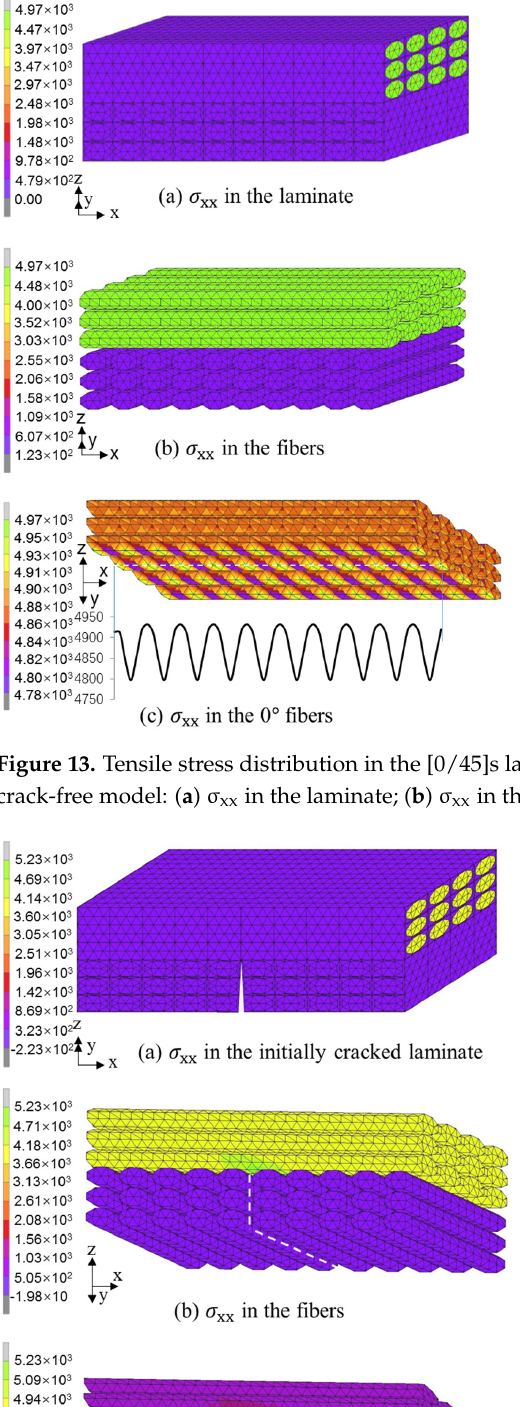
Figure 14. Tensile stress distribution in the [0/45]s laminate under failure stress obtained from the initial crack model: ( a ) σ xx in the laminate; ( b ) σ xx in the fibers; ( c ) σ xx in the 0° fibers.